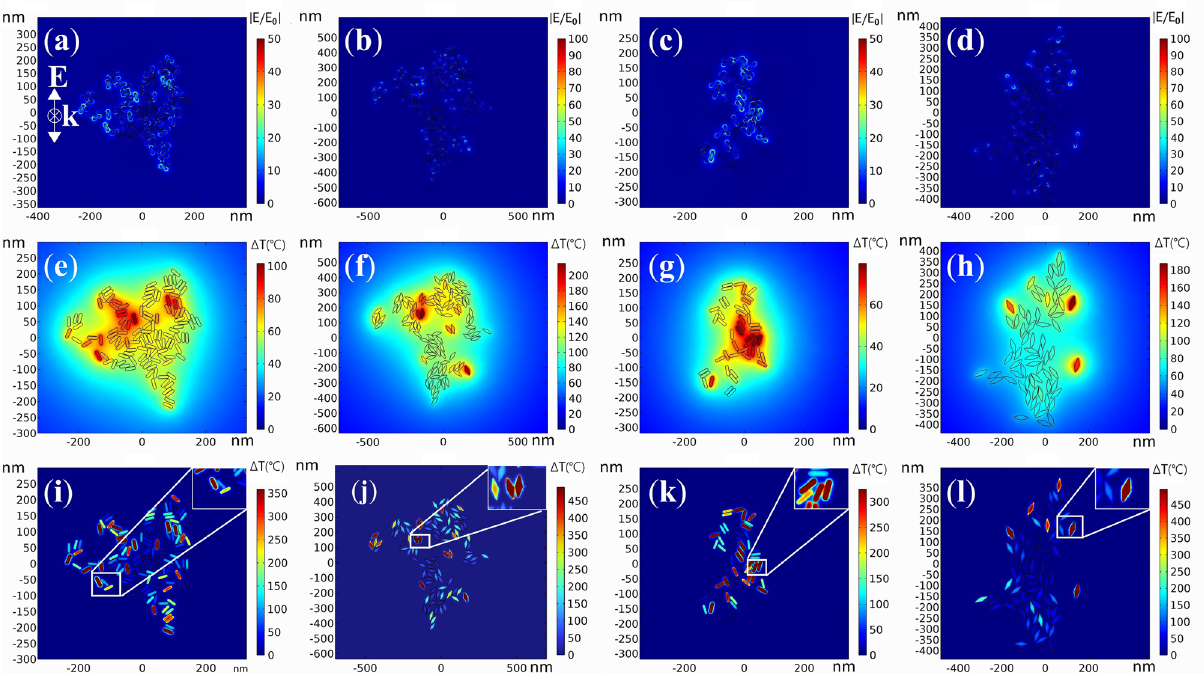
Figure 7. The near-field intensity map of ( a ) GNR (LSPR 760 nm) clusters at 760 nm laser excitation; ( b ) GNB (LSPR 760 nm) clusters at 760 nm laser excitation; ( c ) GNR (LSPR 780 nm) clusters at 780 nm laser excitation; ( d ) GNB (LSPR 780 nm) clusters at 780 nm laser excitation. Rising temperature distribution of: ( e ) GNR (LSPR 760 nm) clusters under 760 nm continuous laser excitation; ( f ) GNB (LSPR 760 nm) clusters under 760 nm continuous laser excitation; ( g ) GNR (LSPR 780 nm) clusters under 780 nm continuous laser excitation; ( h ) GNB (LSPR 780 nm) clusters under 780 nm continuous laser excitation. Rising temperature distribution of ( i ) GNR (LSPR 760 nm) clusters under 760 nm pulse fs laser excitation; ( j ) GNB (LSPR 760 nm) clusters under 760 nm pulse fs laser excitation; ( k ) GNR (LSPR 780 nm) clusters under 780 nm pulse fs laser excitation; ( l ) GNB (LSPR 780 nm) clusters under 780 nm pulse fs laser excitation. The particle distribution in gold nanoclusters in numerical simulation is based on the particle distribution model obtained from the TEM images of cells in Fig.